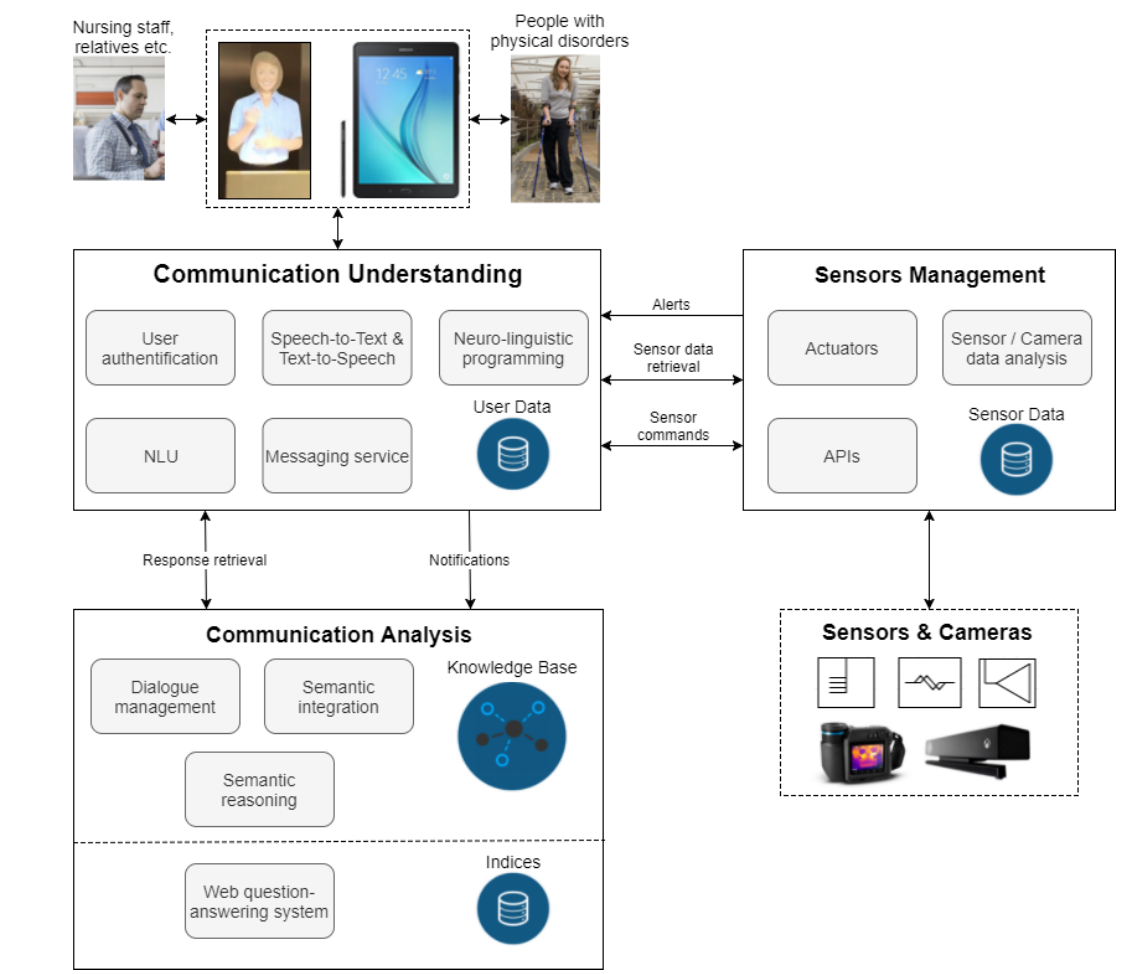
Figure 1. System